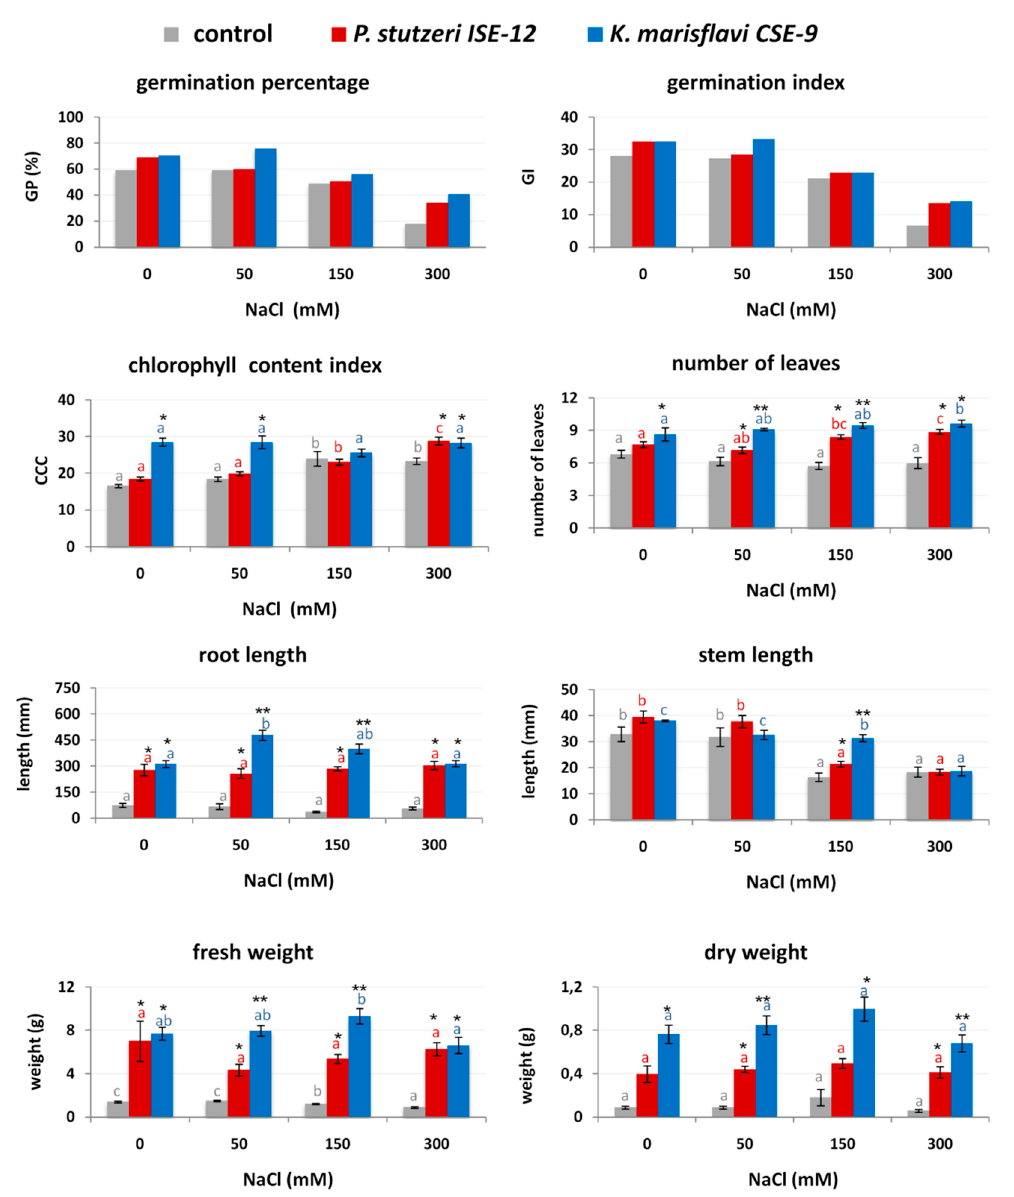
Figure 3. Growth parameters (germination percentage and index, number of leaves, chlorophyll content, length of roots and stems, fresh and dry weight) of B. vulgaris inoculated with P. stutzeri ISE-12 and K. marisflavi CSE-9 cultivated in di ff erent NaCl concentrations (0, 50, 150 and 300 mM NaCl). Significant di ff erences (based on p < 0.05, df, MS and p value, one-way ANOVA with Tukey post hoc comparisons) between variants of experiment (noninoculated control; inoculated with P. stutzeri ISE-12 and K. marisflavi CSE9) in each NaCl concentration are denoted by di ff erent marks * and **, while the e ff ect of salinity for each variant is marked with di ff erent letters (including gray font for control variant, red font in the case of P. stutzeri ISE-12 treated variant and blue font for K. marisflavi CSE-9 inoculated plants). Mean values ± standard error are presented ( n = 4–55, depending on the tested